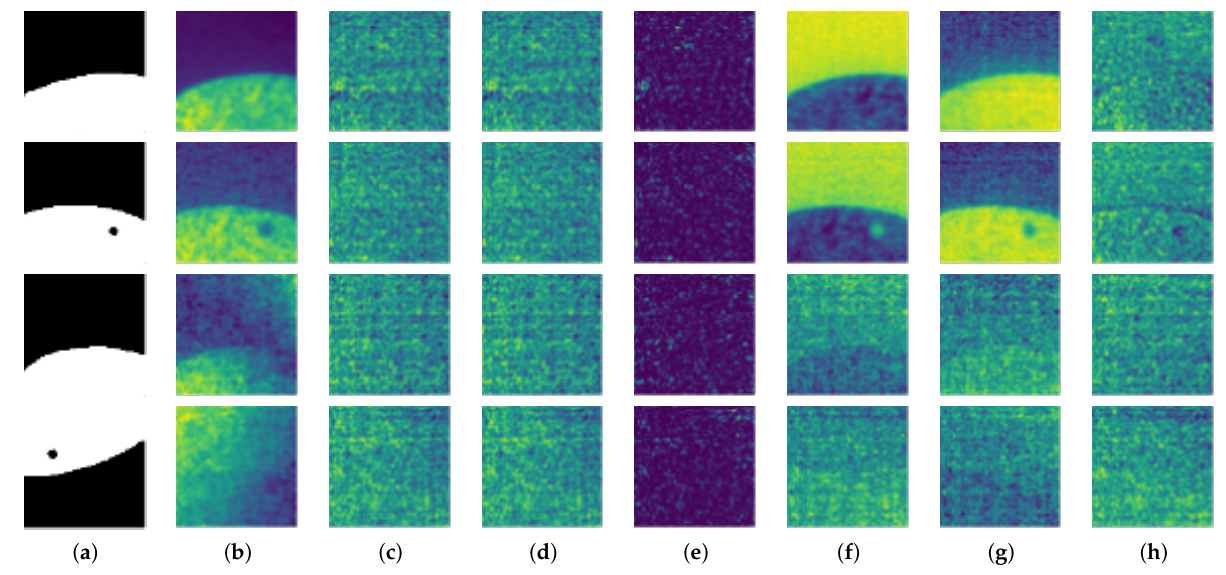
Figure 18. ( a ) Ground truth of the 0.4, 0.7, 1.6, 1.9 m submerged stone disc. ( b ) TUTDF. ( c ) MF. ( d ) CEM. ( e ) ACE. ( f ) OSP. ( g ) SAM. ( h ) TCIMF. Table 5. AUC values calculated from the three 2D ROC curves of different detection results on STONE at various